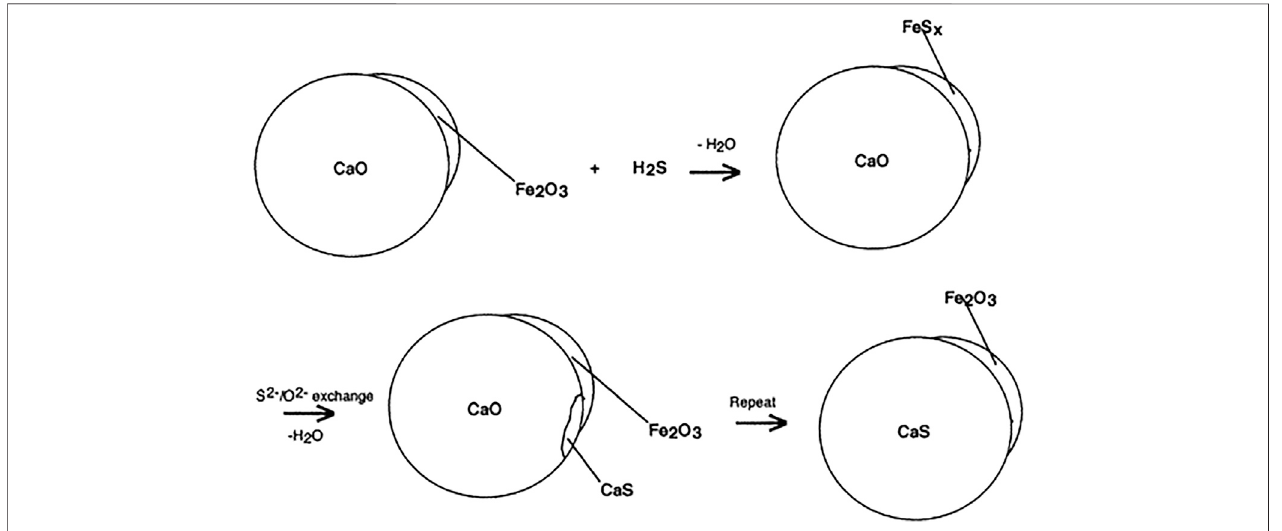
FIGURE 8 | Formation of intermediate species through ion exchange under H 2 S adsorption in Fe 2 O 3 /CaO. Adapted from Carnes and Klabunde (2002) with permission from the American Chemical Society.